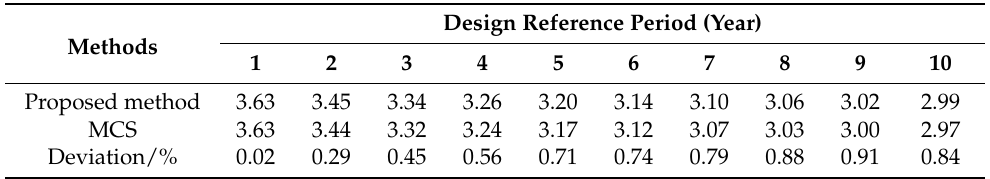
Table 10. Reliability index of the wing surface structure for different design